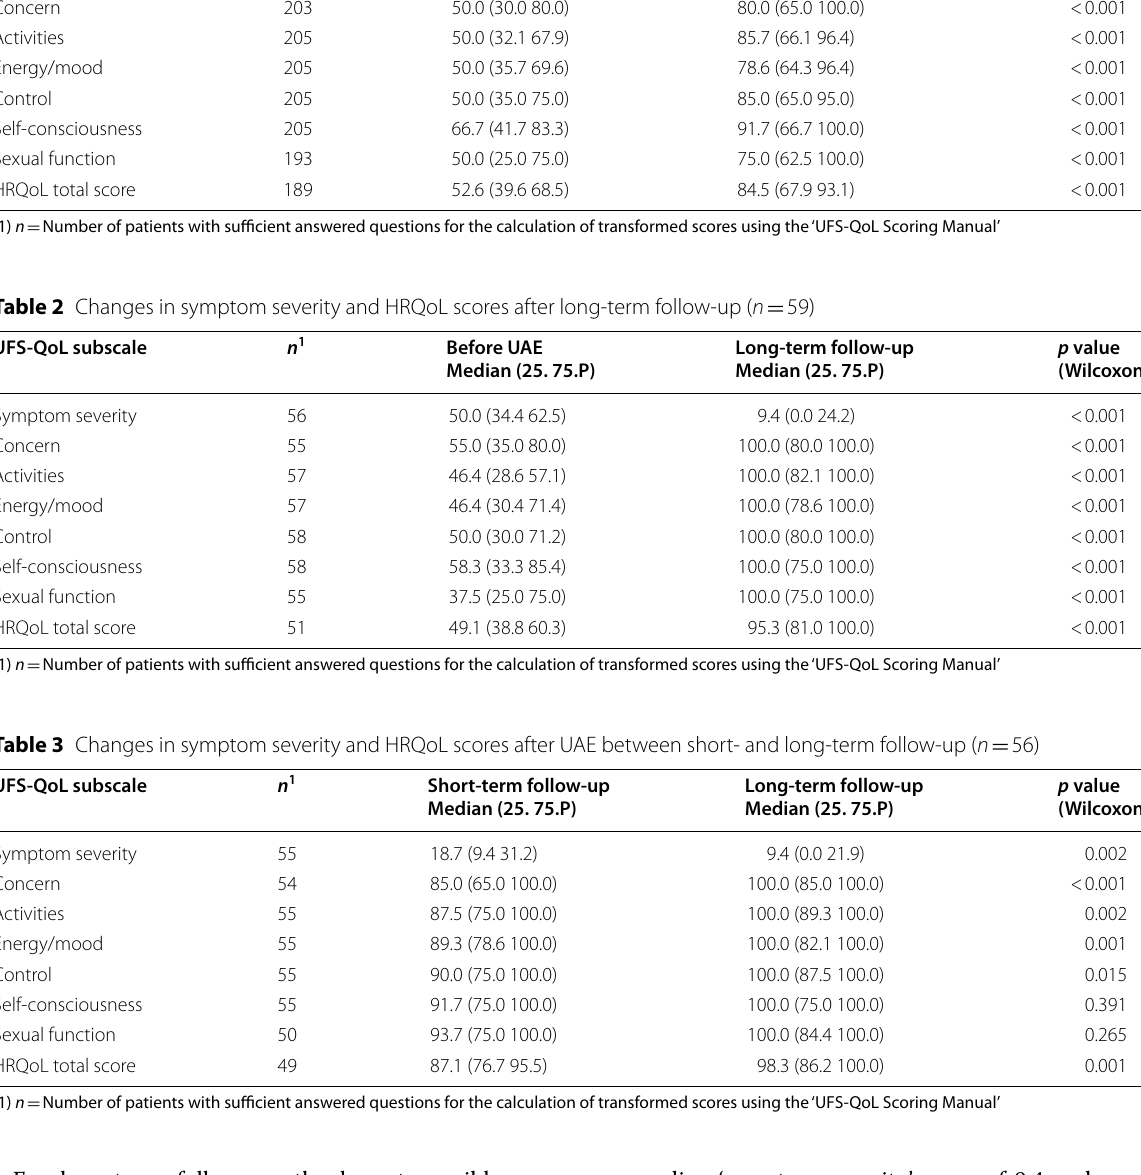
(1) n Number of patients with sufficient answered questions for the calculation of transformed scores using the ‘UFS-QoL Scoring Manual’ =